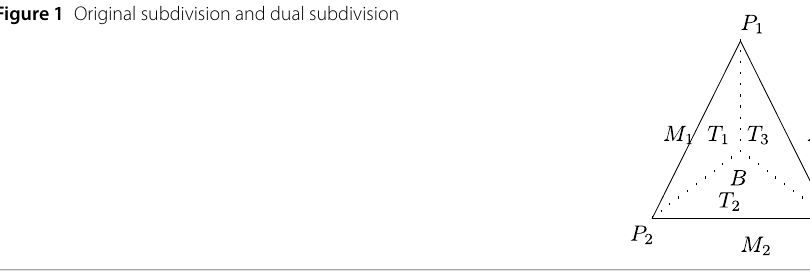
Figure 1 Original subdivision and dual